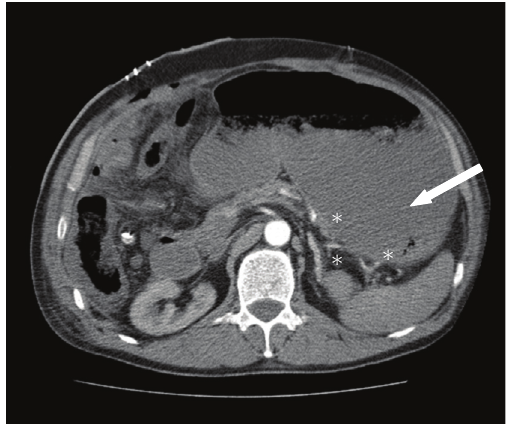
Figure 1: Contrast-enhanced computed tomography scan per- formed 8 days postoperatively (Case 1). The stomach (white arrow) is filled with blood after upper gastrointestinal bleeding from gastro-oesophageal varices secondary to portal hypertension. Multiple large collateral veins run along the stomach and spleen (white